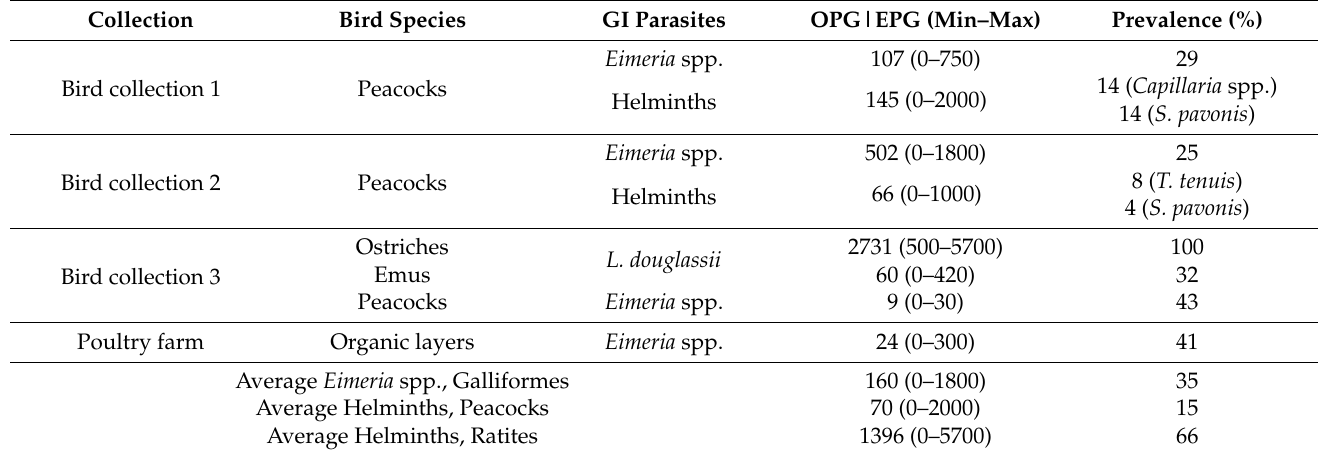
Table 2. Epidemiological results obtained with Mini-FLOTAC for each bird